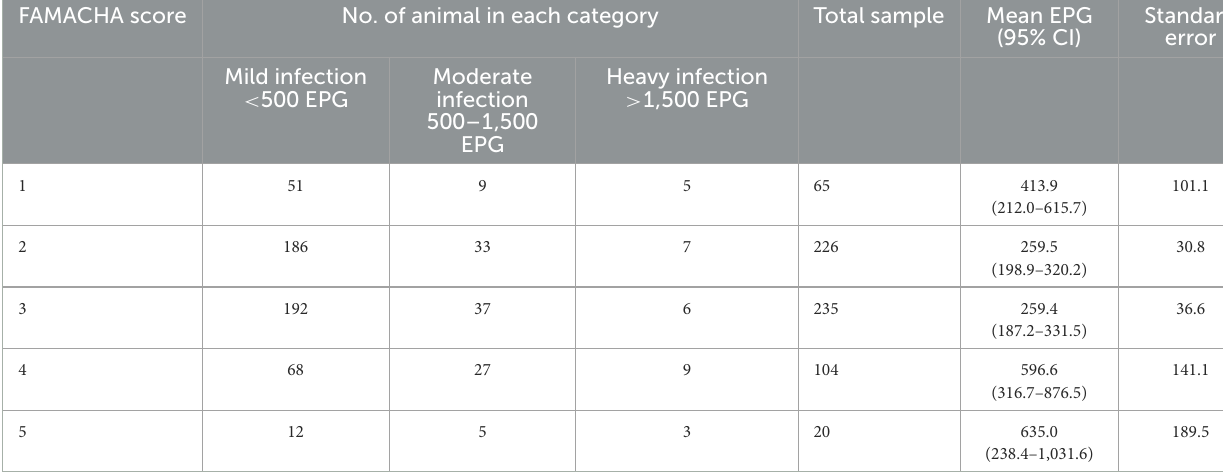
TABLE 8 FAMACHA score and the mean fecal egg count. FAMACHA